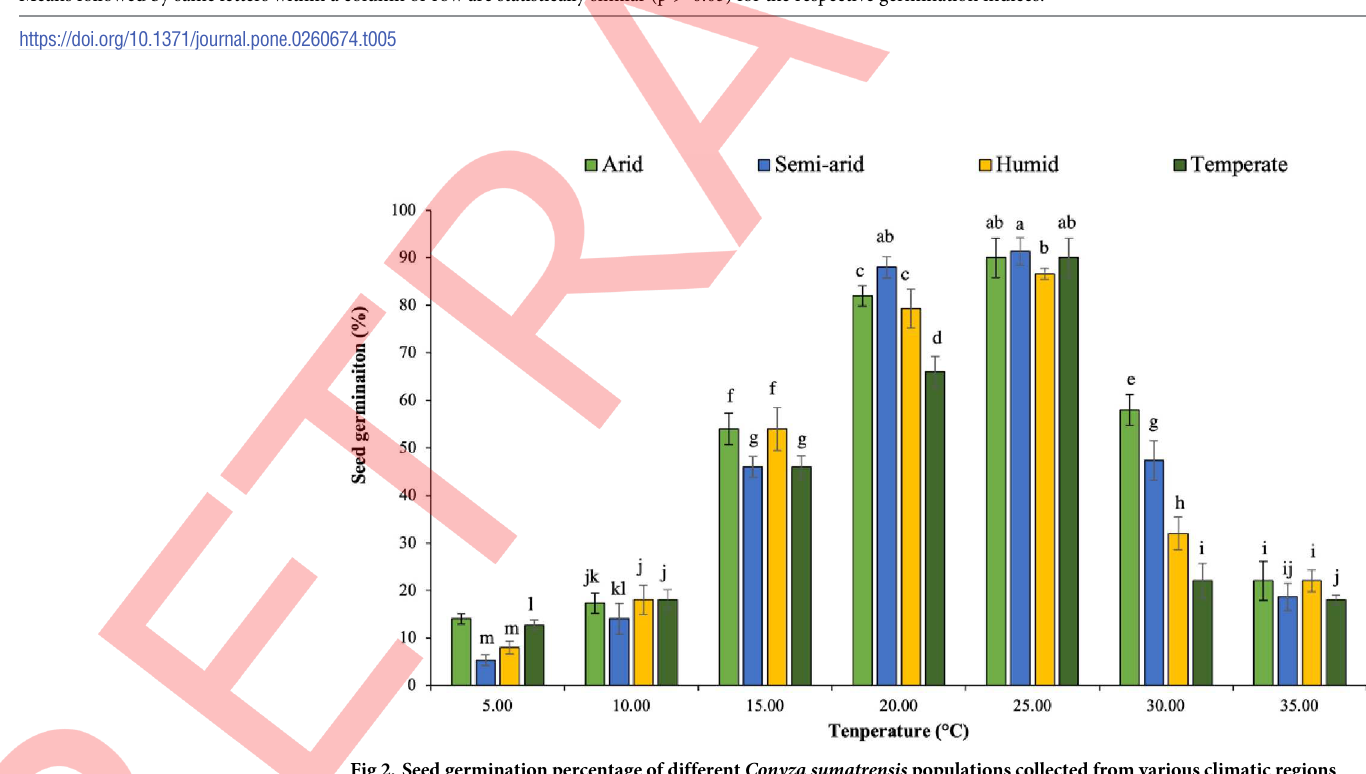
Fig 2. Seed germination percentage of different Conyza sumatrensis populations collected from various climatic regions under different constant temperatures.